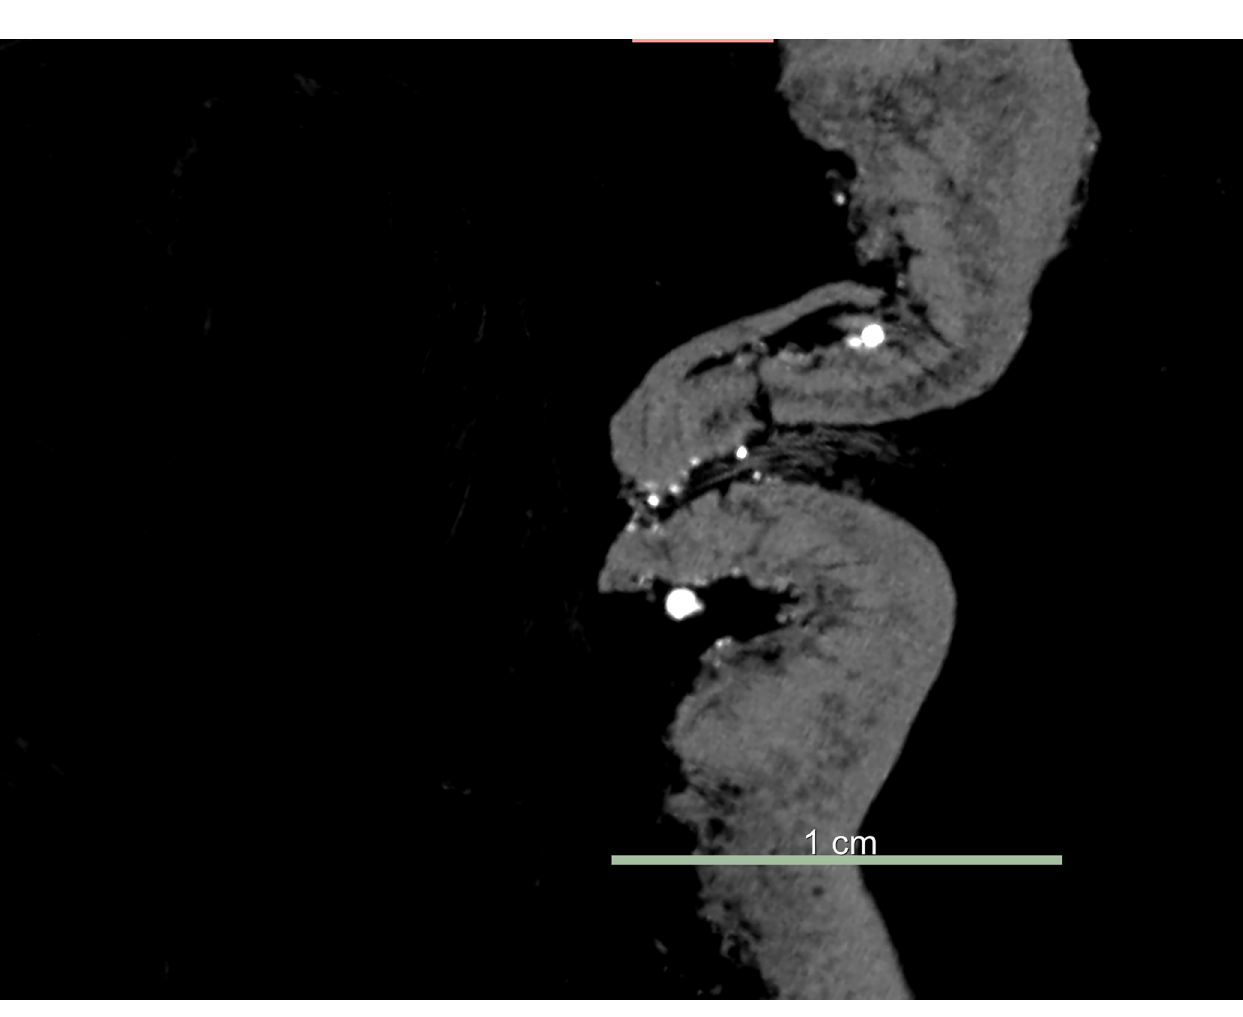
Fig 5. Comparative slice images of the eye at different resolutions. Micro-CT (75 μ m scan) coronal slice through the eye.